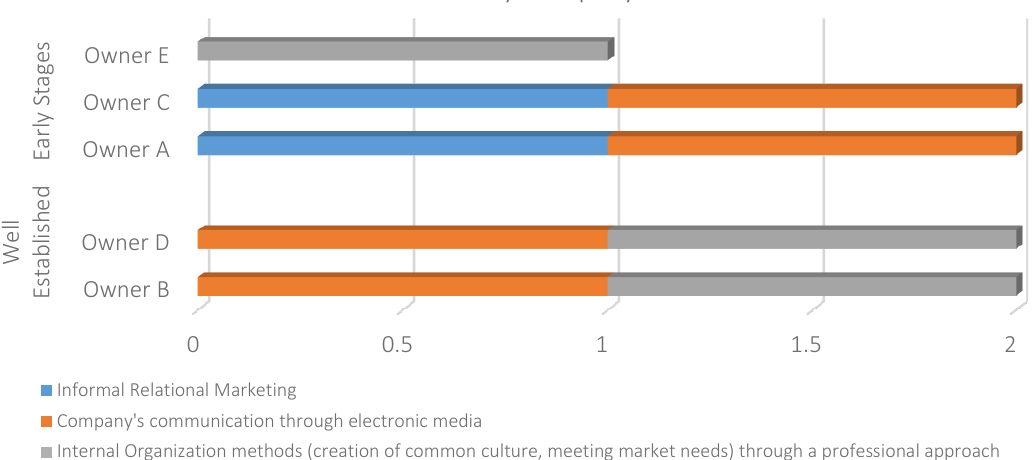
Figure 2. Brand from the family company point of